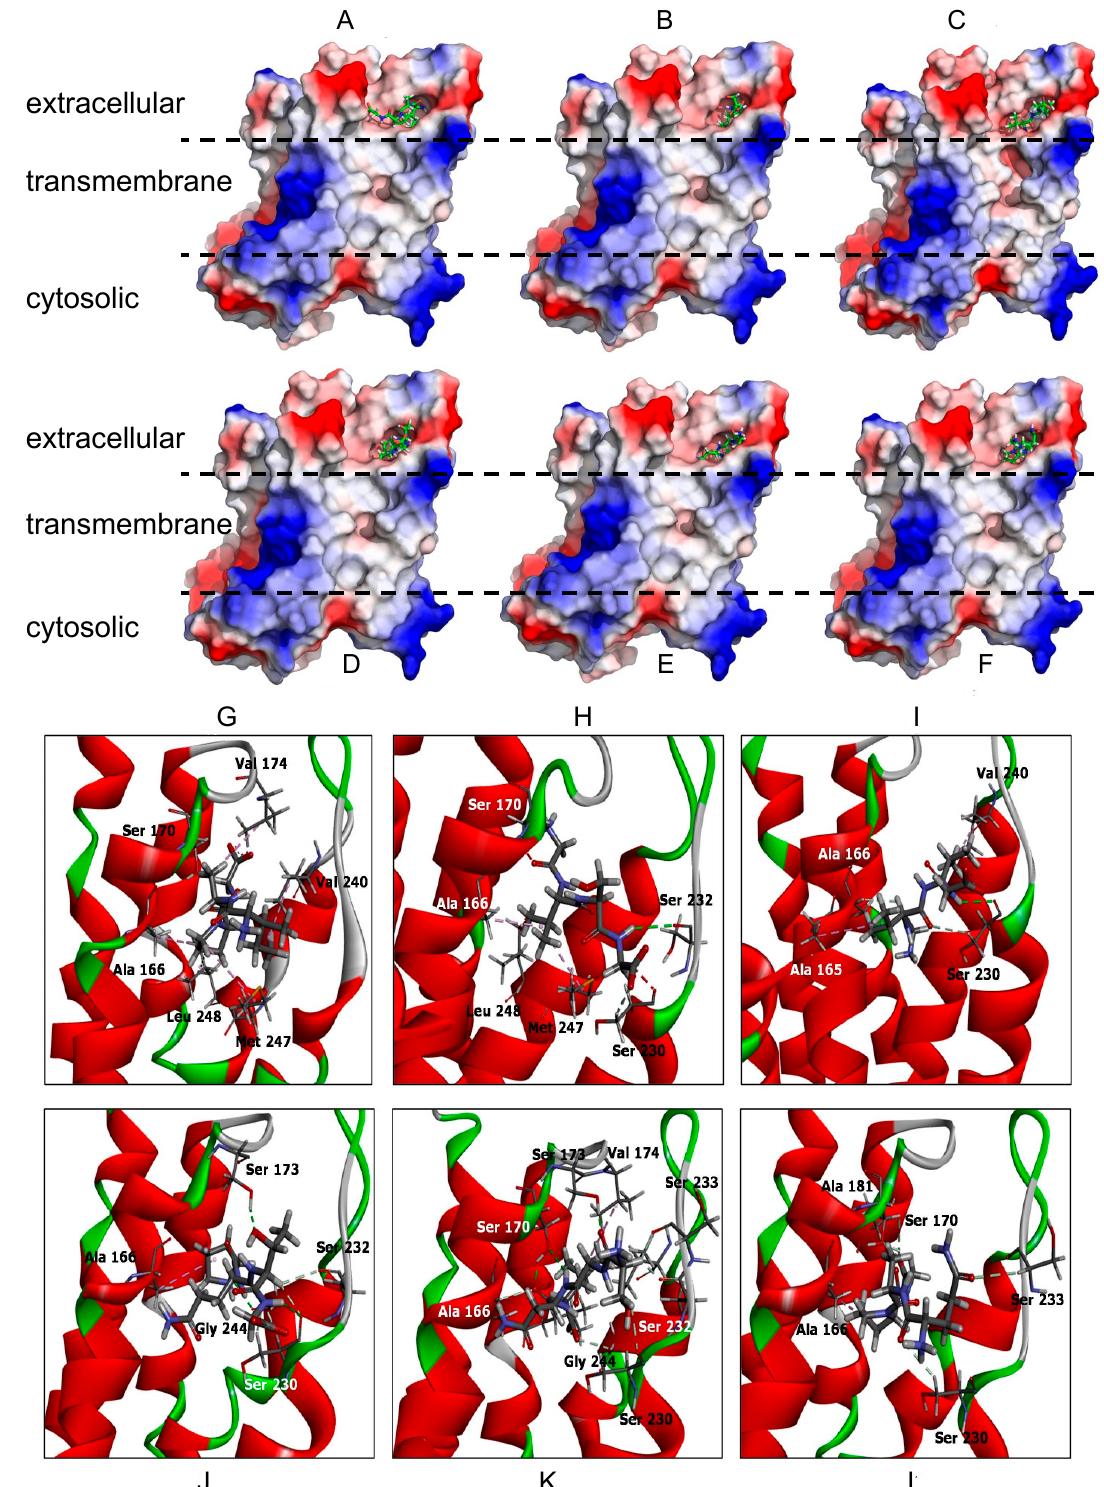
Figure 1. ZIP9-peptide complex model obtained via PepComposer and PatchDoc server. ( A – F ) Complexes formed between ZIP9 and peptides IAPG, GVSG, GVVG, PQTG, SGNL, and QAPG, respectively. All of them bind within the predicted extracellular androgen binding site of the protein. ( G – L ) ZIP9–peptide complex models showing molecular details of interactions of all amino acid residues from the androgen binding site whose side chains are involved in direct interactions with the peptides IAPG, GVSG, GVVG, PQTG, SGNL, and QAPG, respectively.